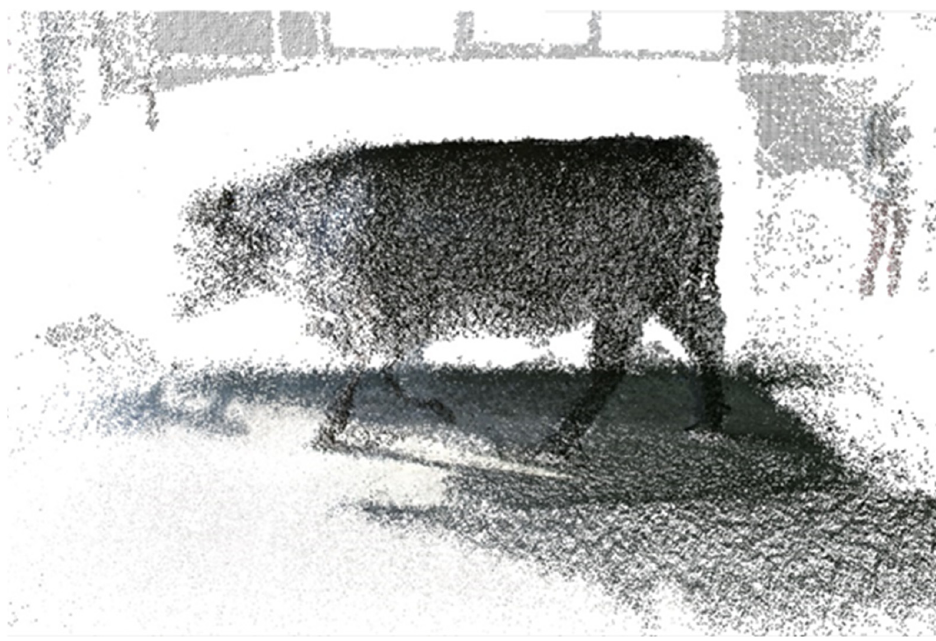
Figure 2. 3-D point cloud model of the cattle using the proposed system for 3-D reconstruction.